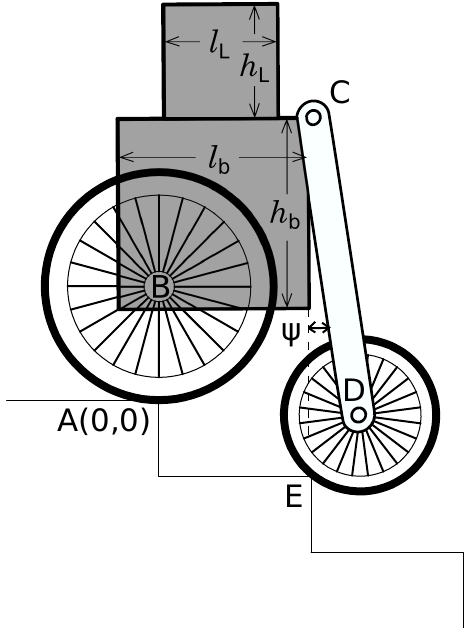
Figure 5. Schematic for actuator length calculation while